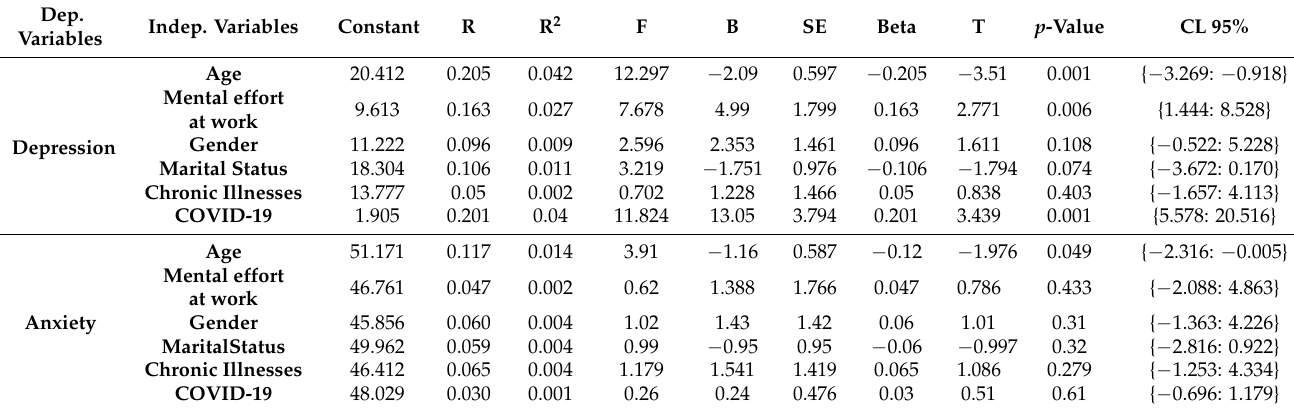
Table 3. Predictors of depression or anxiety in the Egyptian population. Linear regression tests were used to determine factors that significantly correlated with depression and anxiety. Linear-regression-dependent (dep.) variables included depression or anxiety, whereas the independent (indep.) variables included age, gender, mental effort at work, marital status, chronic illnesses, and COVID-19 disease. Dep. Variables